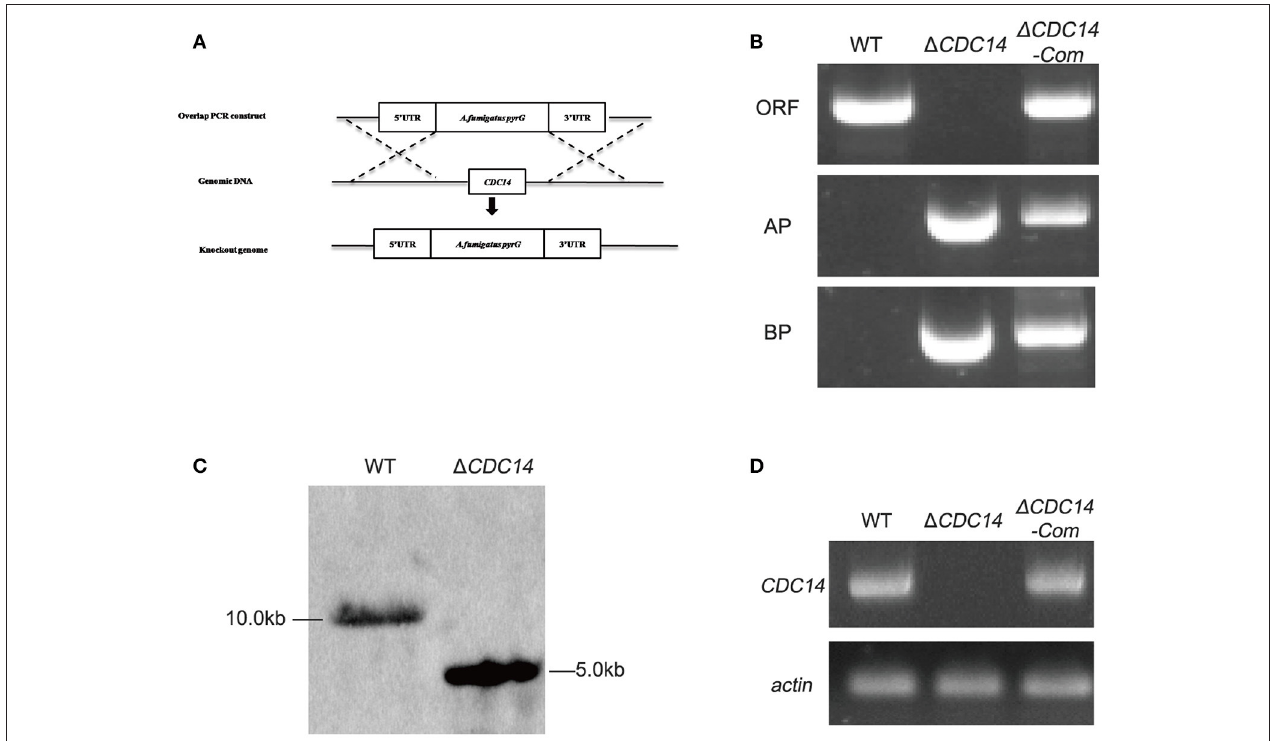
FIGURE 2 | Construction of the AflCDC14 deleted ( 1 CDC14 ) and complemented ( 1 CDC14 -Com) strains. (A) Deletion strategy for 1 CDC14 by using homologous recombination. (B) 1 CDC14 and 1 CDC14 -Com strains were verified by PCR analysis with genomic DNA as template. (C) Southern blot analysis of WT and 1 CDC14 strains. Genomic DNA from each strain was digested with Hind III and hybridized with a 1.0kb probe of the upstream region fragment of AflCDC14 gene. (D) RT-PCR was used to detect the transcript levels of AflCDC14 in different strains, and actin was used as the endogenous